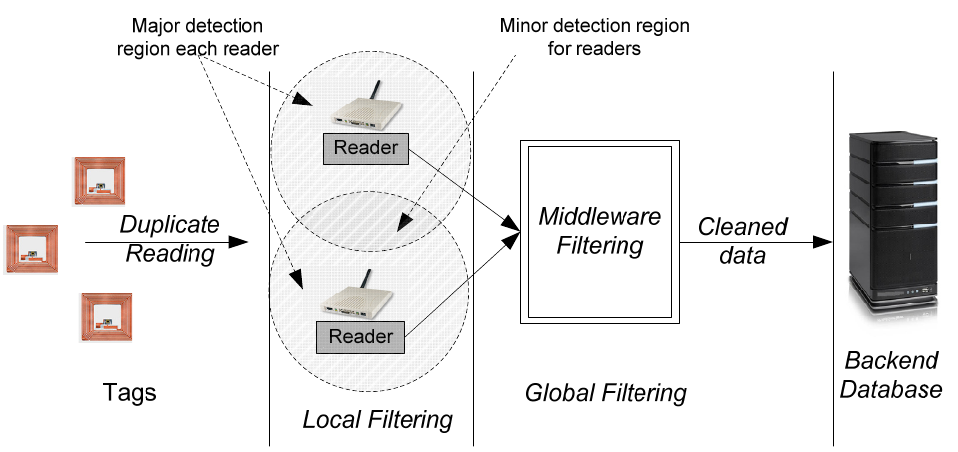
Figure 2. Multi-level RFID data filtering approach.